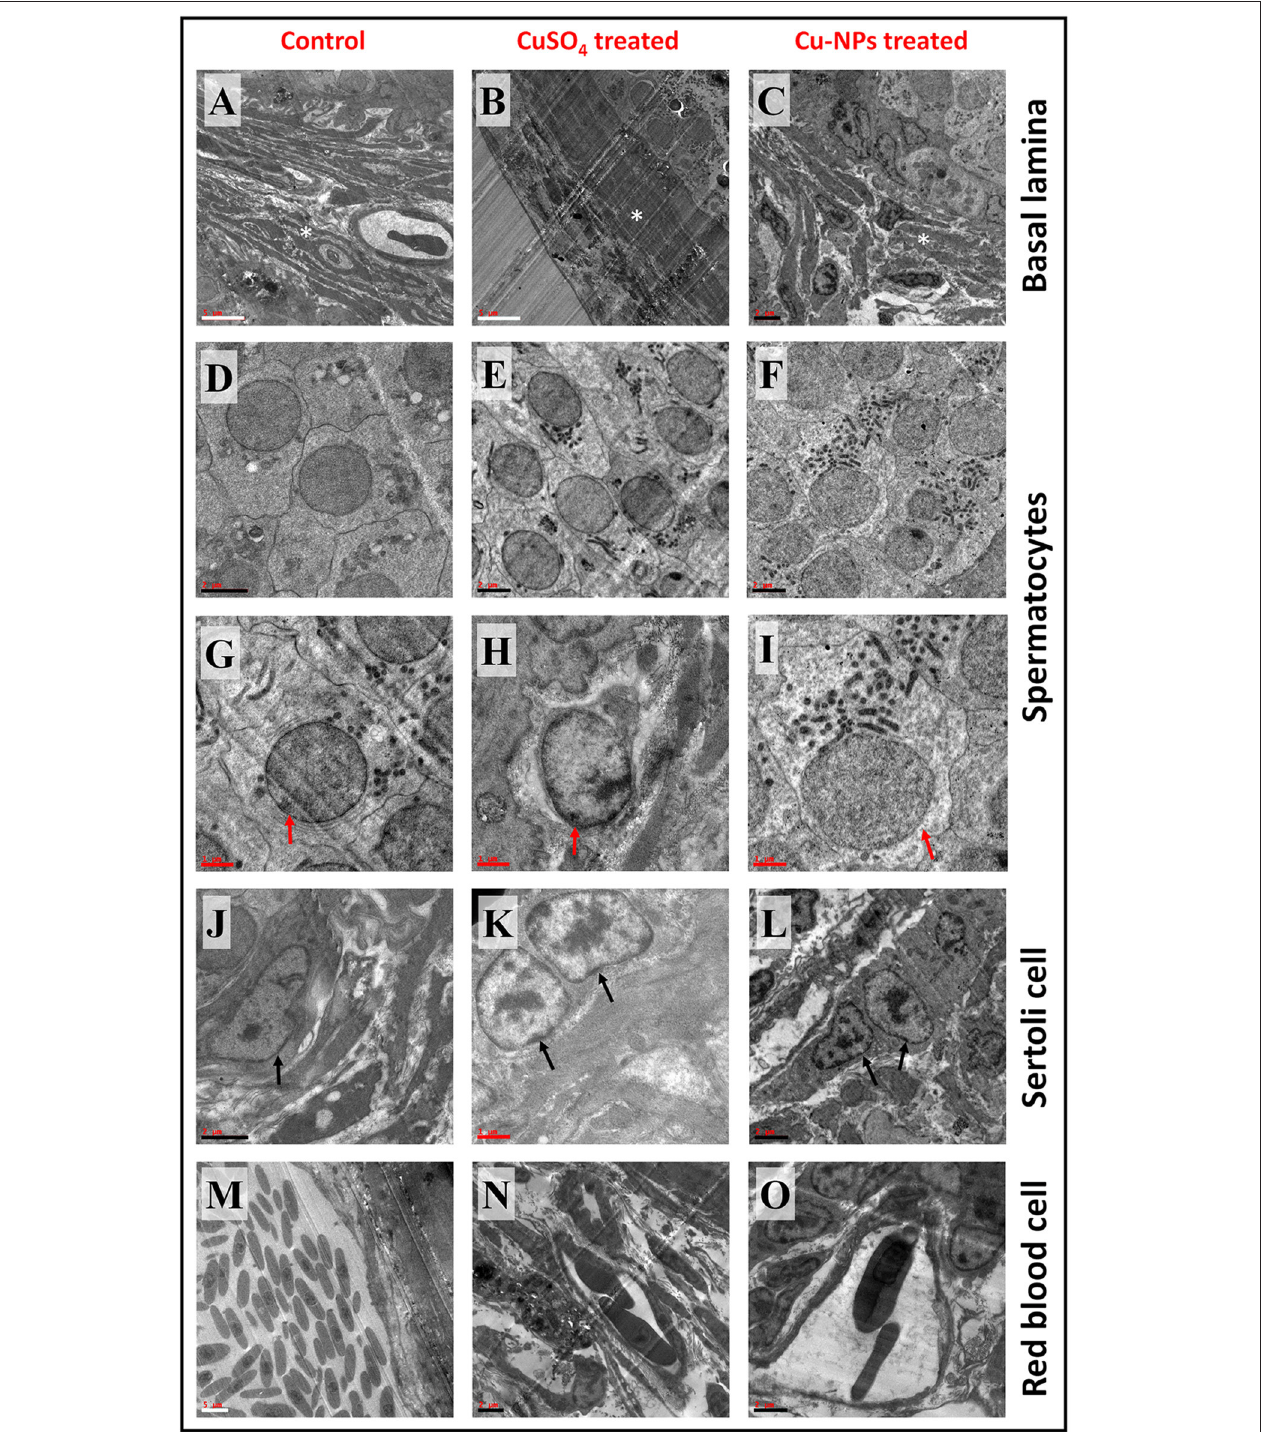
FIGURE 4 | Transmission electron microscope (TEM) representative images of basal lamina (BL), Spermatocyte (SC), Sertoli (ST) cell and red blood cell (RBC) of control and treated catfish. Control testis (A,D,G,J,M) indicates normal appearance of BL, SC, ST, and RBC. CuSO 4 treated testis (B,E,H,K,N) showing disruption in BL, irregular SC and ST with disruption in nuclear membrane and distinct RBC. Cu-NPs treated testis (C,F,I,L,O) displayed degenerated BL, apoptotic SC and ST with disappearance of nuclear membrane and deformability of RBC. * indicates BL, red and black arrow indicates SC and ST, respectively. Scale bar: white bar—5 µ m; black bar—2 µ m and red bar—1 µ m.